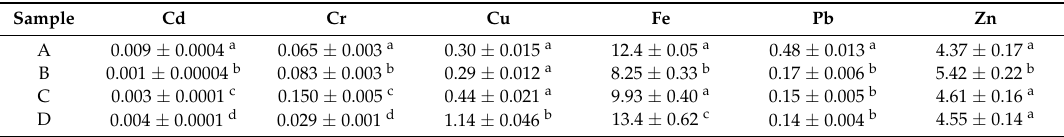
Table 2. The content of elements in the lingonberry